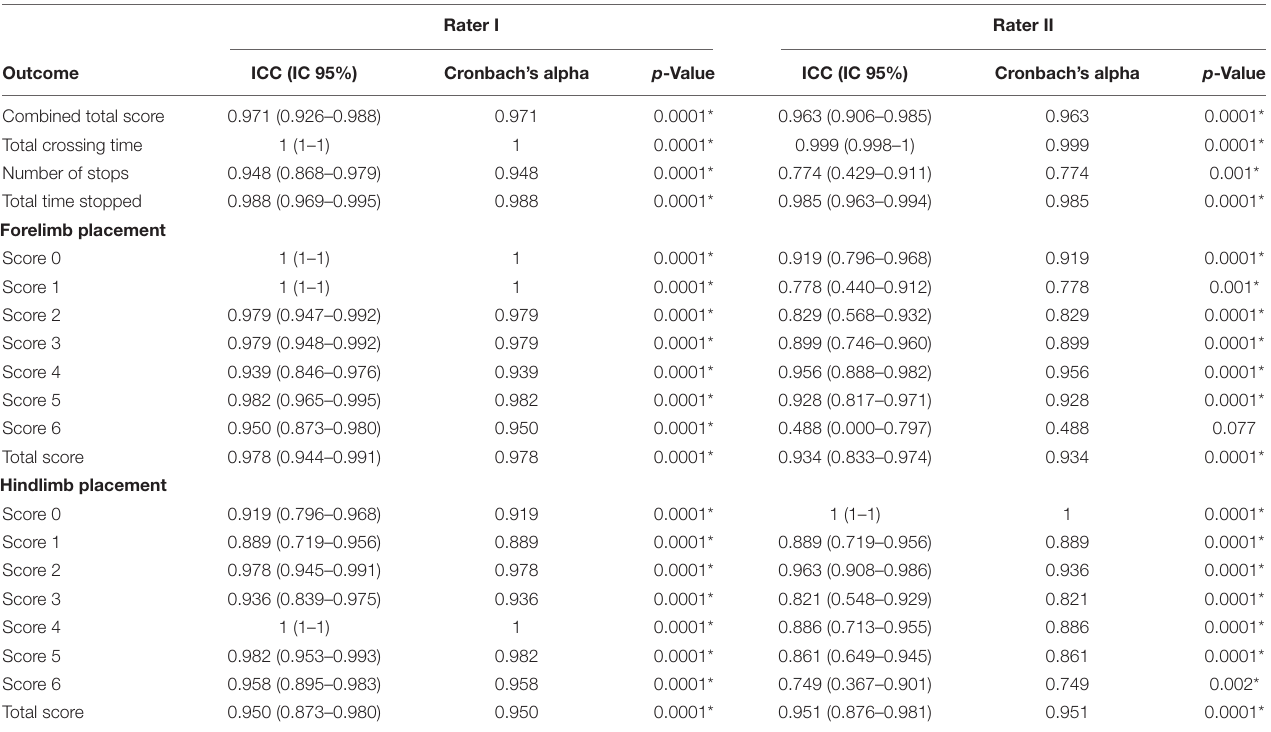
TABLE 5 | Intra-rater agreement on outcomes in the analyses of the LRWT in